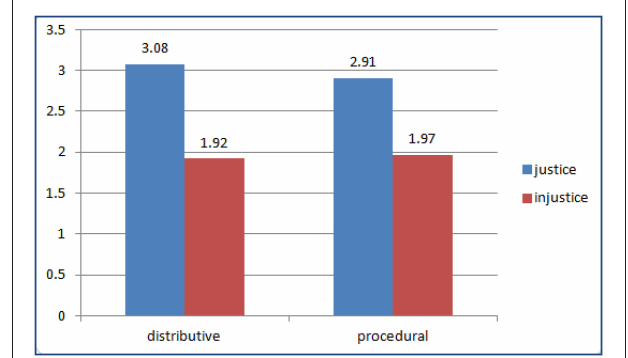
FIGURE 2 | Experimental operational effectiveness of dependent variable.